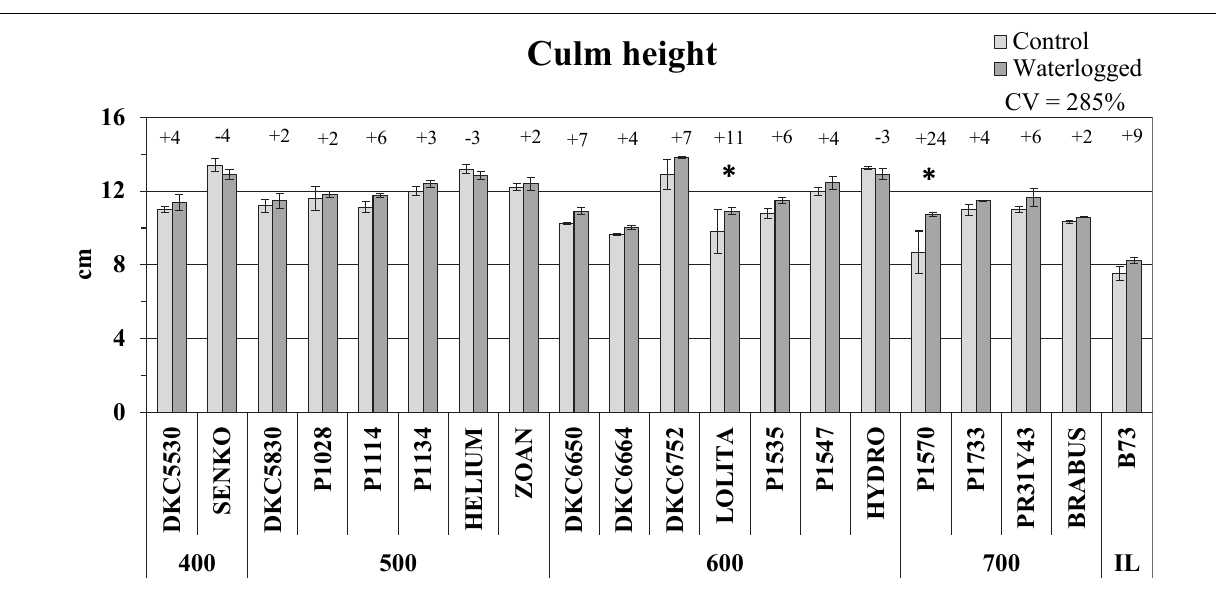
FIGURE 2 | Culm height (average ± SE; n = 3) of control and waterlogged plants of commercial hybrids and the inbred line B73 at 17 DAS, grouped according to FAO class of maturity (from 400 to 700). Numbers above histograms indicate the percentage variation between waterlogged plants and controls for each hybrid, with asterisks indicating significance ( P ≤